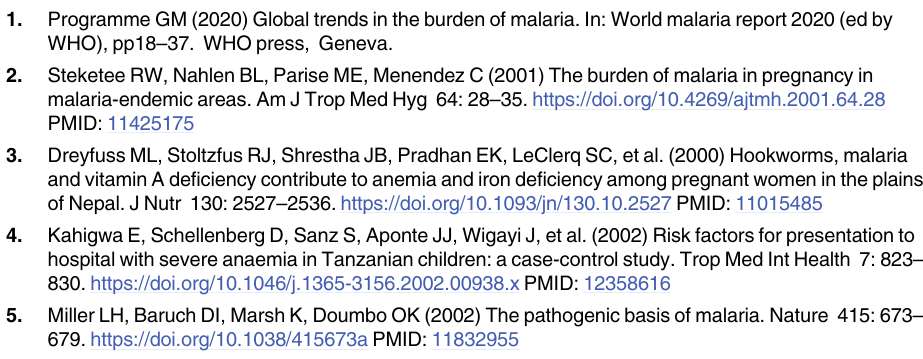
S2 Table. Comparative proteomic analysis of mammary gland tissue in uninfected or infected pregnant mice. The proteome of mammary gland tissues in pregnant mice infected with Pb ANKA on day 5 post-infection was compared with the proteomes in uninfected virgin and pregnant mice, as well as infected virgin and pregnant mice. Proteins showing one or two peptide spectral matches (PSMs) were excluded. Protein levels were normalized to actin, cyto- plasmic 1 (Accession: P60710). S3 Table. Pregnancy outcomes in pregnant mice infected with Pb ANKA. Mice on day 12 post-mating were injected with 1 × 10 4 erythrocytes that had been infected with luciferase- expressing Plasmodium berghei ( Pb ) ANKA. The number, survival rate, and weight of pups were measured on day 0 post-delivery. Experiments using three mice were performed in dupli- cate with similar results. Asterisks indicate a significant difference ( P < 0.05, compared with the pregnancy period of uninfected mice; Tukey-Kramer and Dunnett